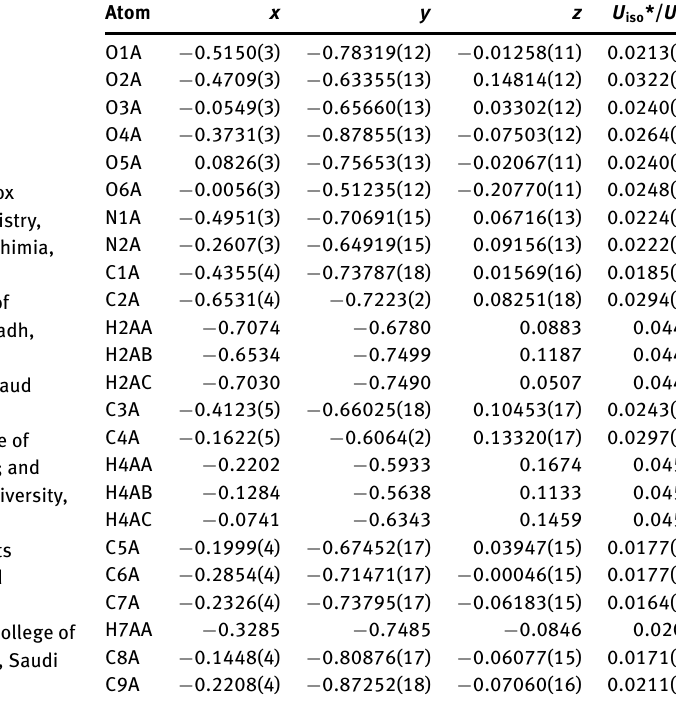
Table 2: Fractional atomic coordinates and isotropic or equivalent isotropic displacement parameters (Å 2